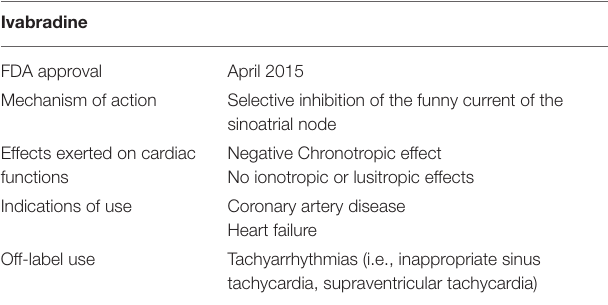
(AVRT), atrioventricular nodal re-entrant tachycardia (AVNRT), junctional ectopic tachycardia, supraventricular tachycardia,